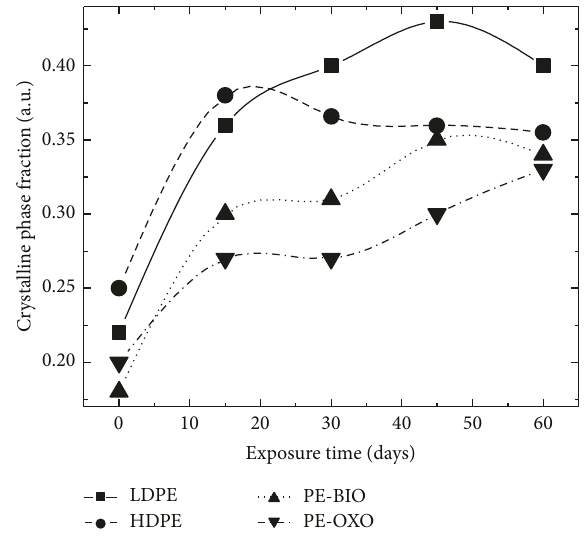
Figure 4: Crystalline phase fraction of the LDPE ( ◼ ), HDPE ( e ), PE-BIO ( 󳵳 ), and PE-OXO ( 󳶃 ) films exposed to UV-B radiation.